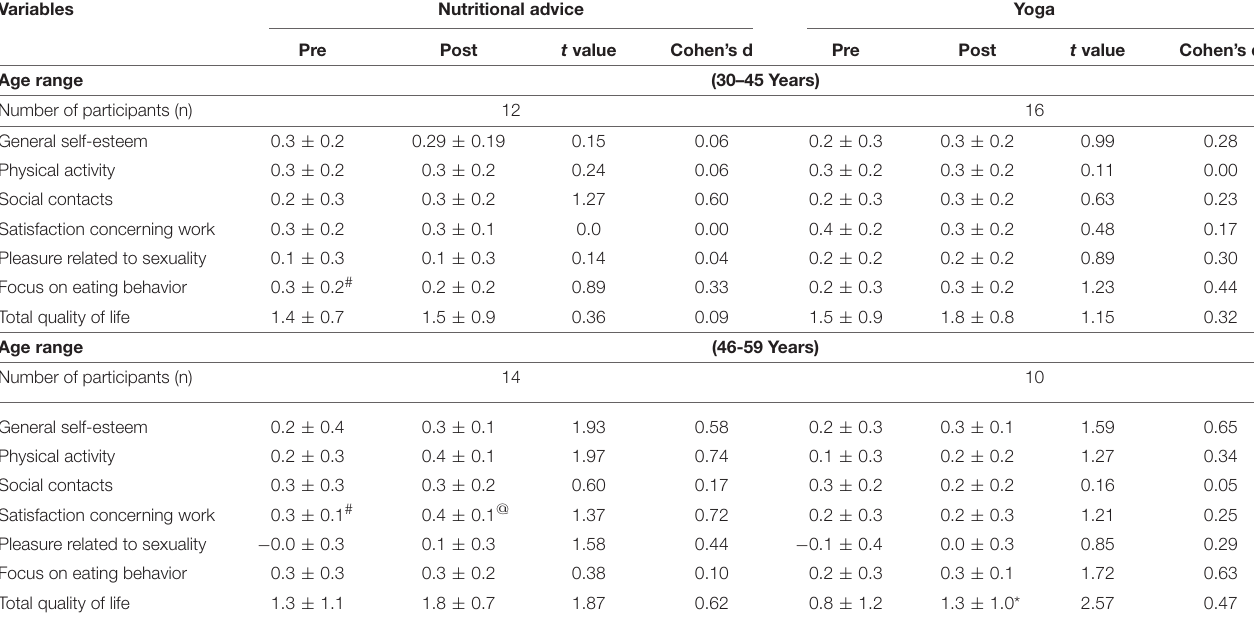
Variables Nutritional advice